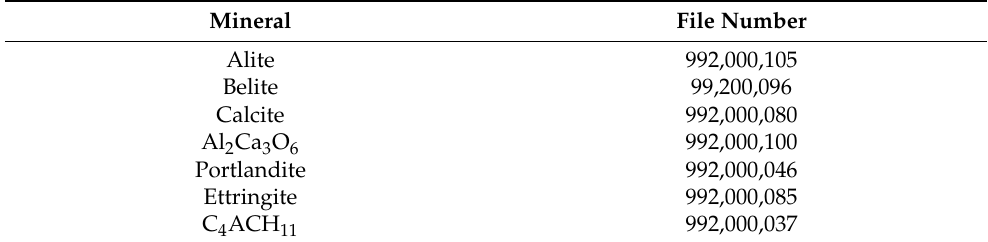
Table 4. Crystallography Open Database (COD) files used for Rietveld quantification.